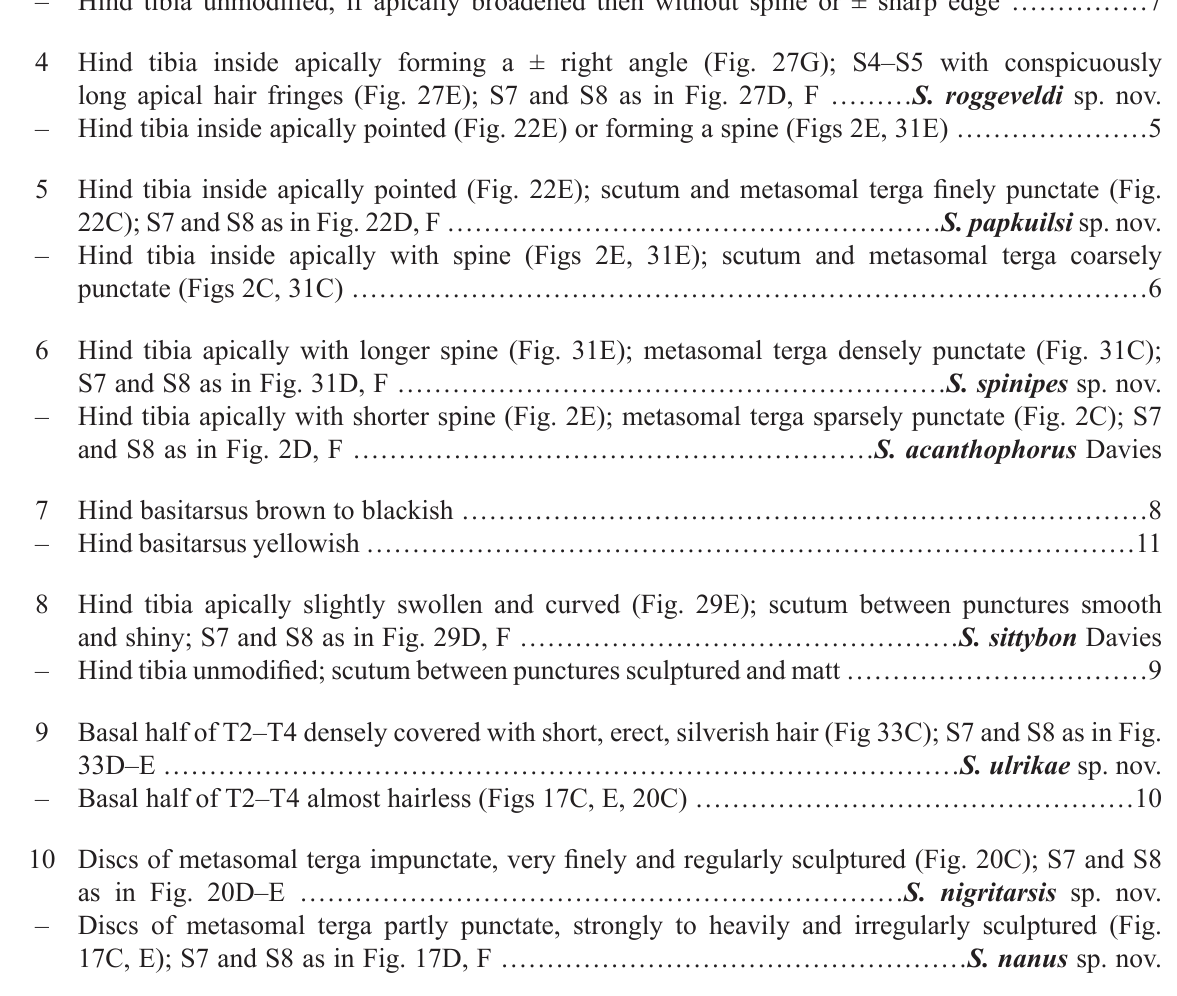
The males of the following three species are very similar and can be best separated by S7 and S8. 12 S7 without membraneous apicolateral lobes (Fig. 13D); S8 as in Fig. 13E … S. minutissimus sp. nov. – 13 S7 apically with emargination slightly broader and shallower (Fig. 5D) …… S. albitarsis (Friese) – S7 apically with emargination slightly narrower and deeper (Fig. 7D) ……… S. exiguus sp.